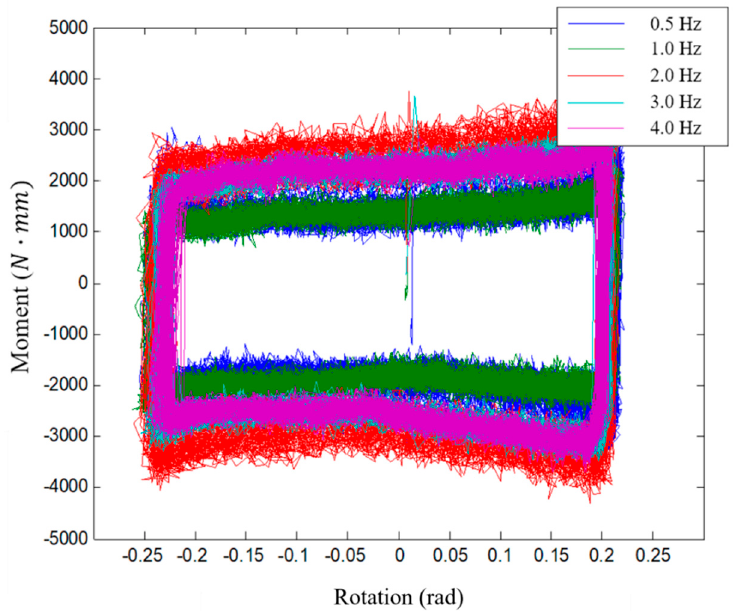
Figure 20. Frequency dependence test results.